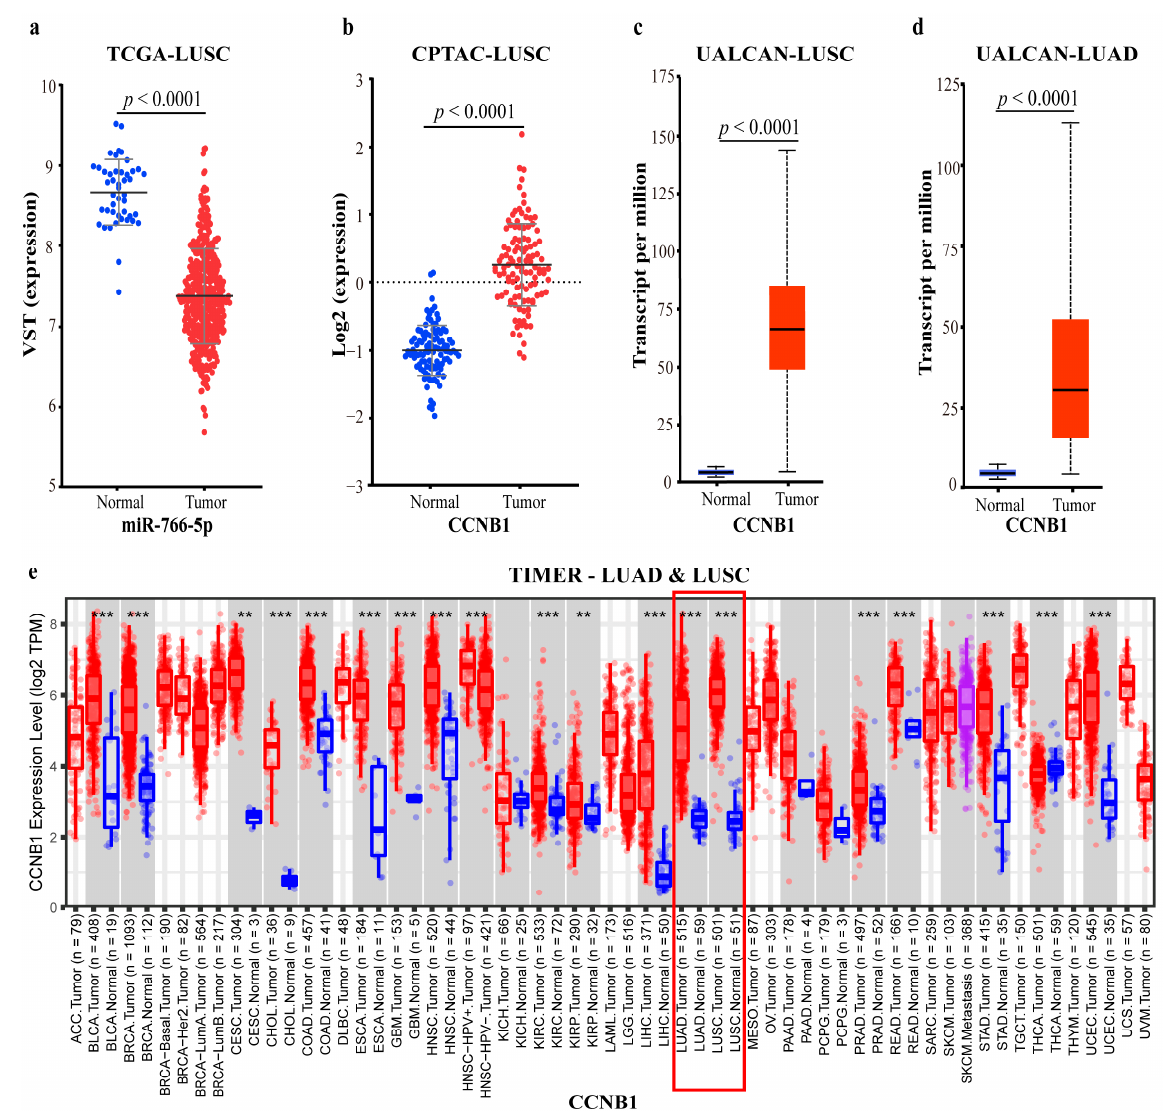
Figure 18. Expression data of miR-766-5p and related gene: ( a ) MiRNA-766-5p expression data of LUSC in TCGA; ( b ) CCNB1 proteome expression data of LUSC in CPTAC; ( c ) CCNB1 mRNA expression data of LUSC in UALCAN; ( d ) CCNB1 mRNA expression data of LUAD in UALCAN; ( e ) CCNB1 mRNA expression data of LUAD and LUSC in TIMER. The blue dots/boxs indicate the normal samples, while the red dots/boxs indicate the tumor samples. *: p < 0.05; **: p < 0.01; ***: p < 0.001.